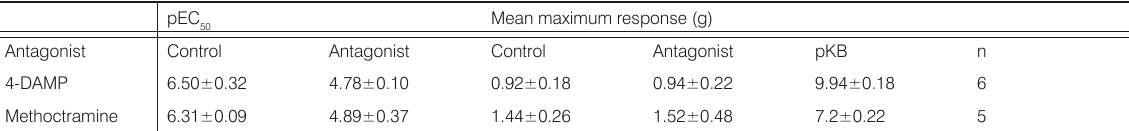
Figure 2. Antagonism of detrusor responses to carbachol by methoctramine (3µM). Cumulative concentration- response curves to carbachol in the absence and presence of methoctramine. Responses are expressed as a percentage of the maximum response obtained for the first curve (pKB= 7.2±0.22).